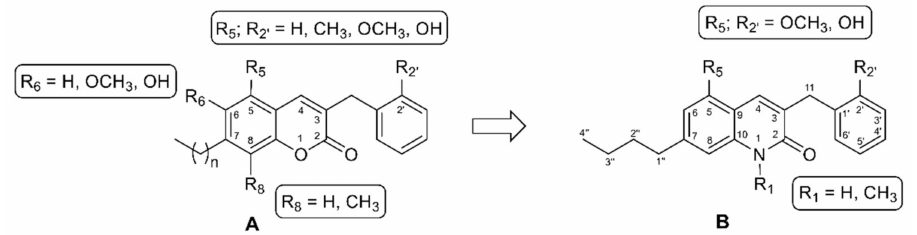
Figure 3. Structural modifications providing the novel series of 3-benzylquinolin-2(1 H )-ones ( B ) from 3-benzylcoumarins ( A